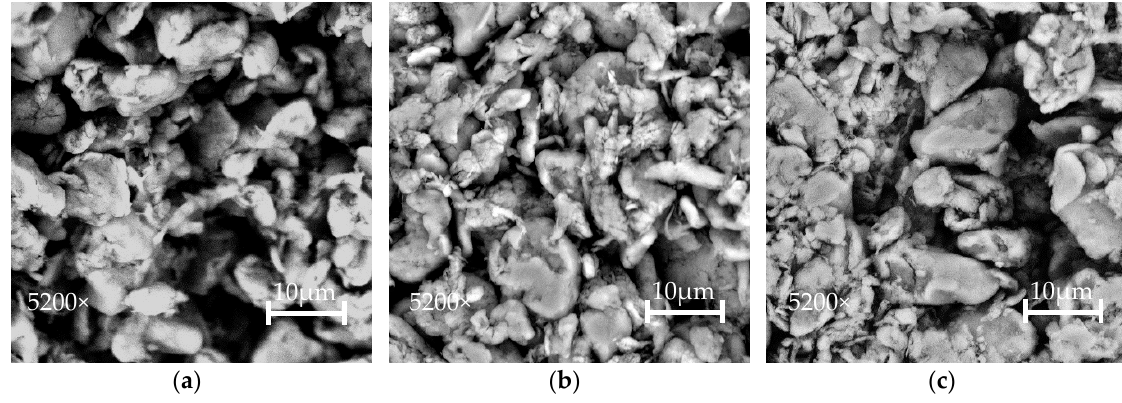
Figure 1. SEM micrographs of PTFE particles etched for ( a ) 2.9 min; ( b ) 10 min; or ( c ) 17.1 min.